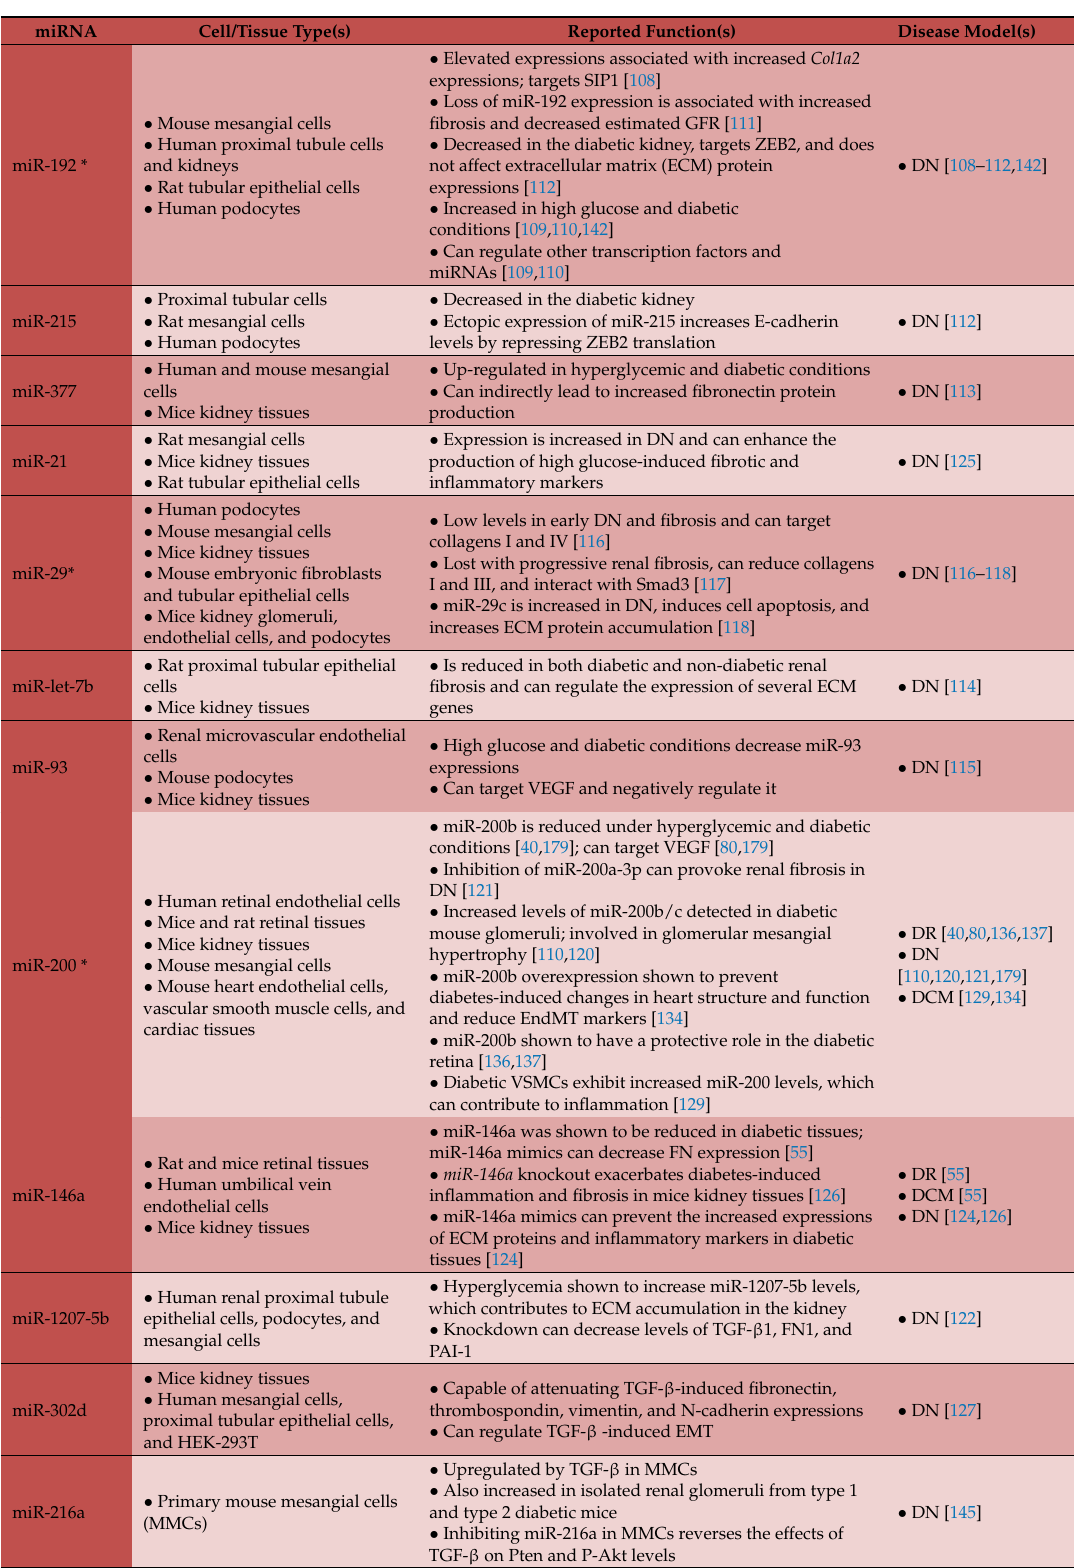
Table 1. Examples of certain micro RNAs (miRNAs) implicated in